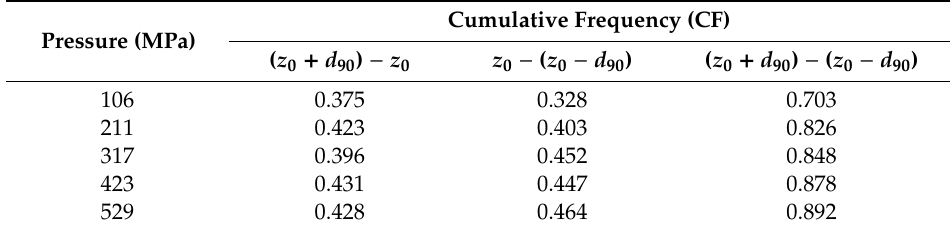
Table 4. Cumulative frequency of surface profile near the support